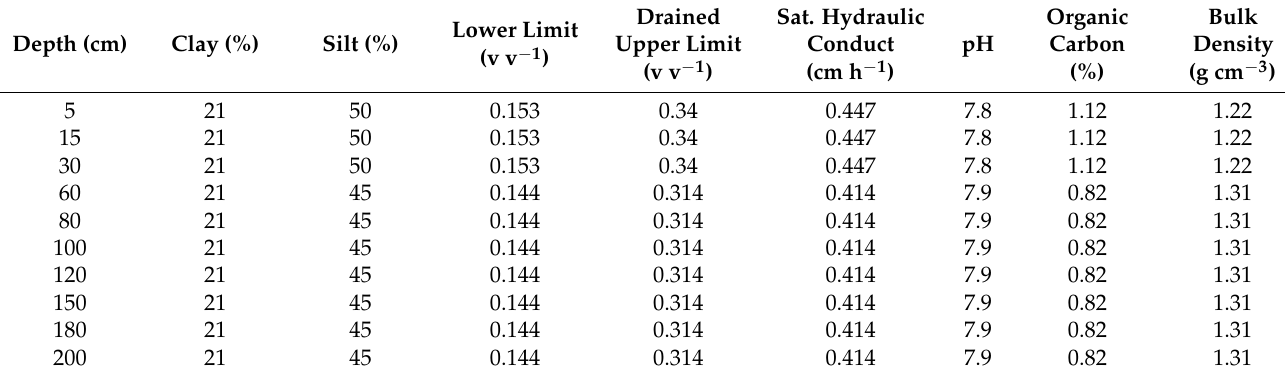
Table 2. Soil properties of the experimental